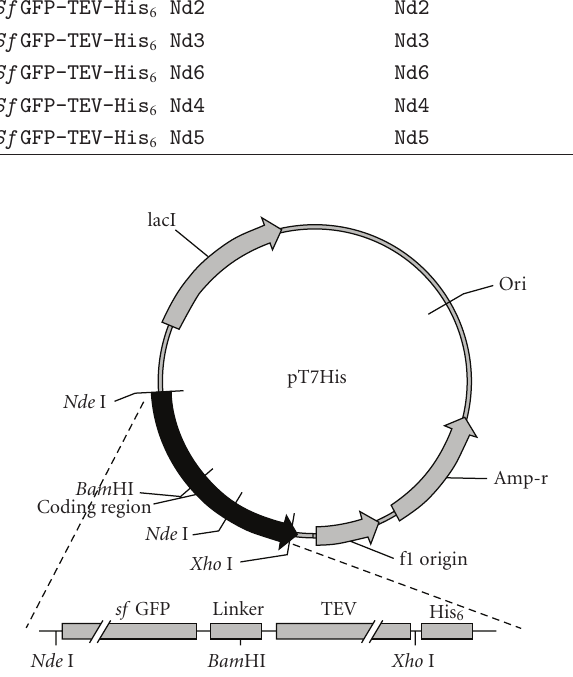
Figure 1: Maps of expression vector for sf GFP-TEV-His 6 Nd1– 6 used in our work. The vector map was created by Vector NTI software. All variants of sf GFP-TEV-His 6 use the same vector pT7His derived from pET21a. The coding region in black will produce sf GFP-TEV-His 6